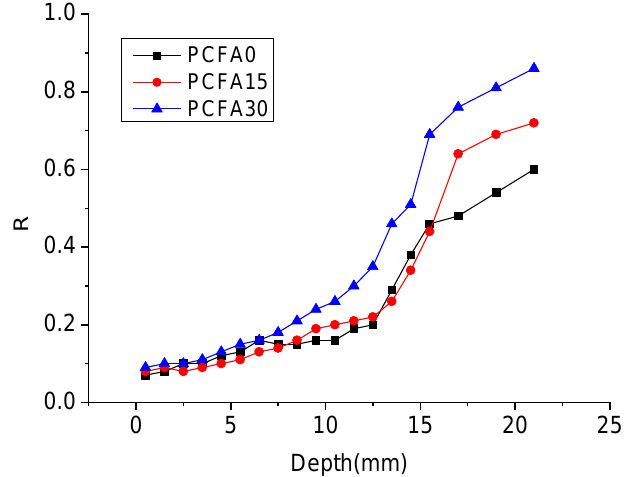
Figure 8. Relation between chloride bound capacity amount and concrete depth.